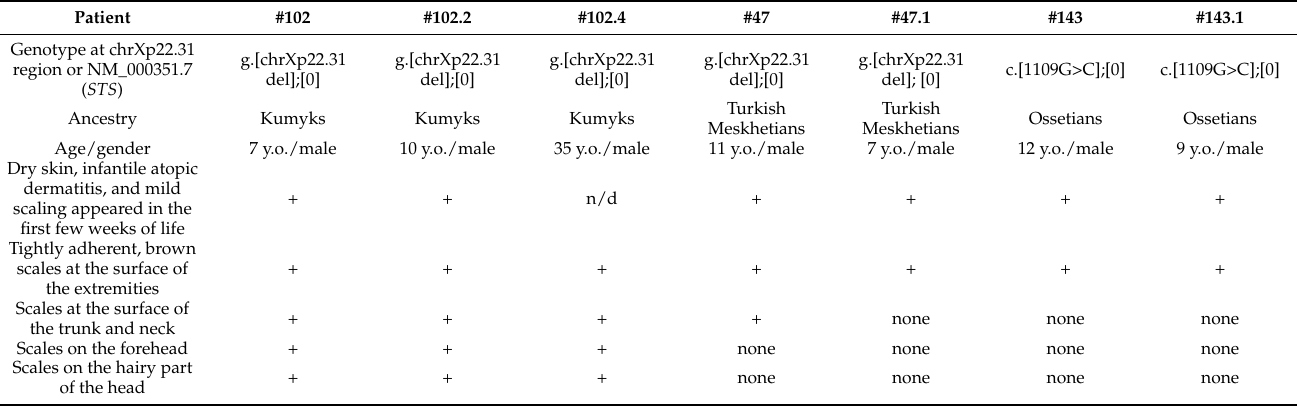
Table 1. Patients’ presentation, clinical picture, and genotype of seven patients with XLI from